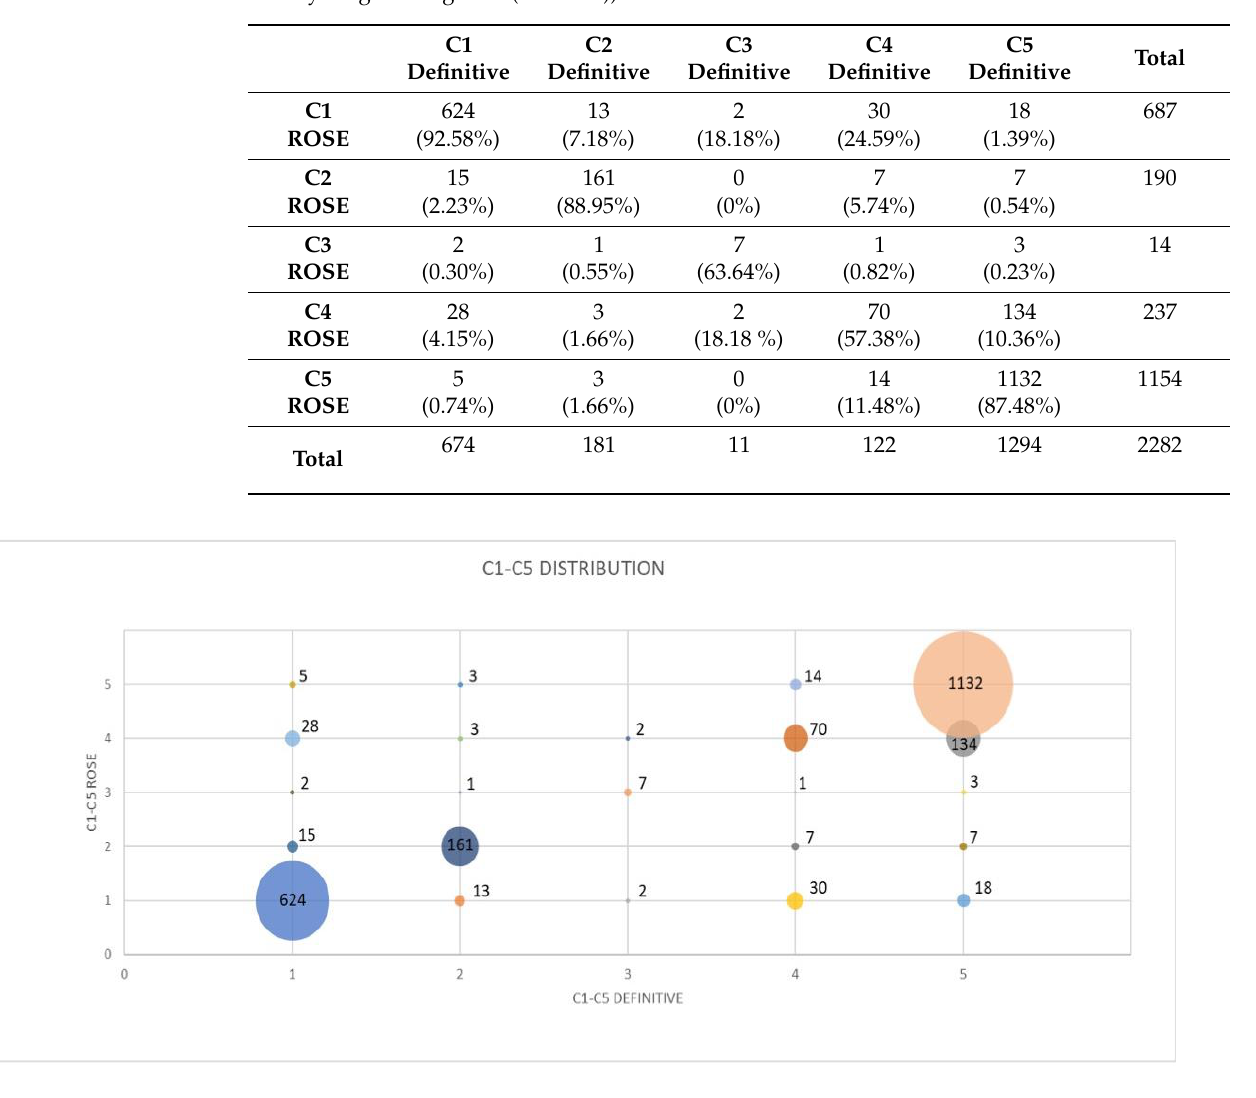
Figure 2. Bubble graph of C1–C5 distribution as evaluated using ROSE and by final cytological diagnosis.